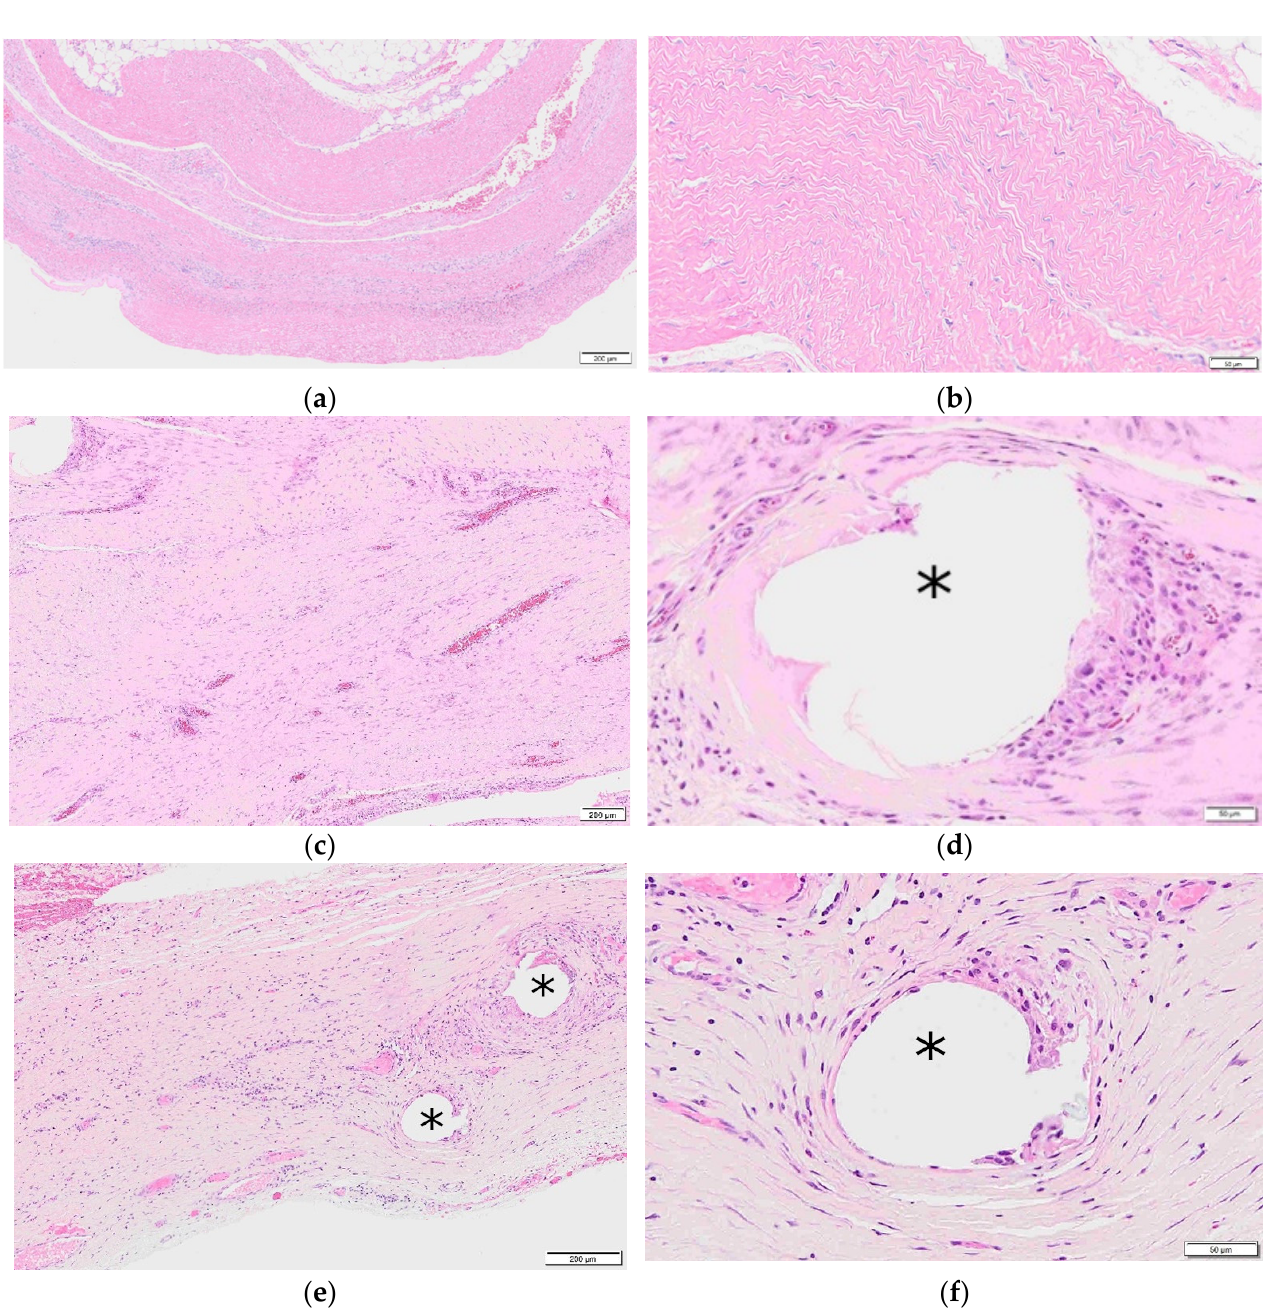
Figure 3. RTM clinical biopsies. * Denotes polypropylene fiber; ( a ) 6 month RTM clinical biopsy, scale bar is 200 µm; ( b ) 6 month RTM clinical biopsy, scale bar is 50 µm; ( c ) 7 month RTM clinical biopsy, scale bar is 200 µm; ( d ) 7 month clinical biopsy, scale bar is 50 µm; ( e ) 23 month RTM clinical biopsy, scale bar is 200 µm; ( f ) 23 month RTM clinical biopsy, scale bar is 50 µm .